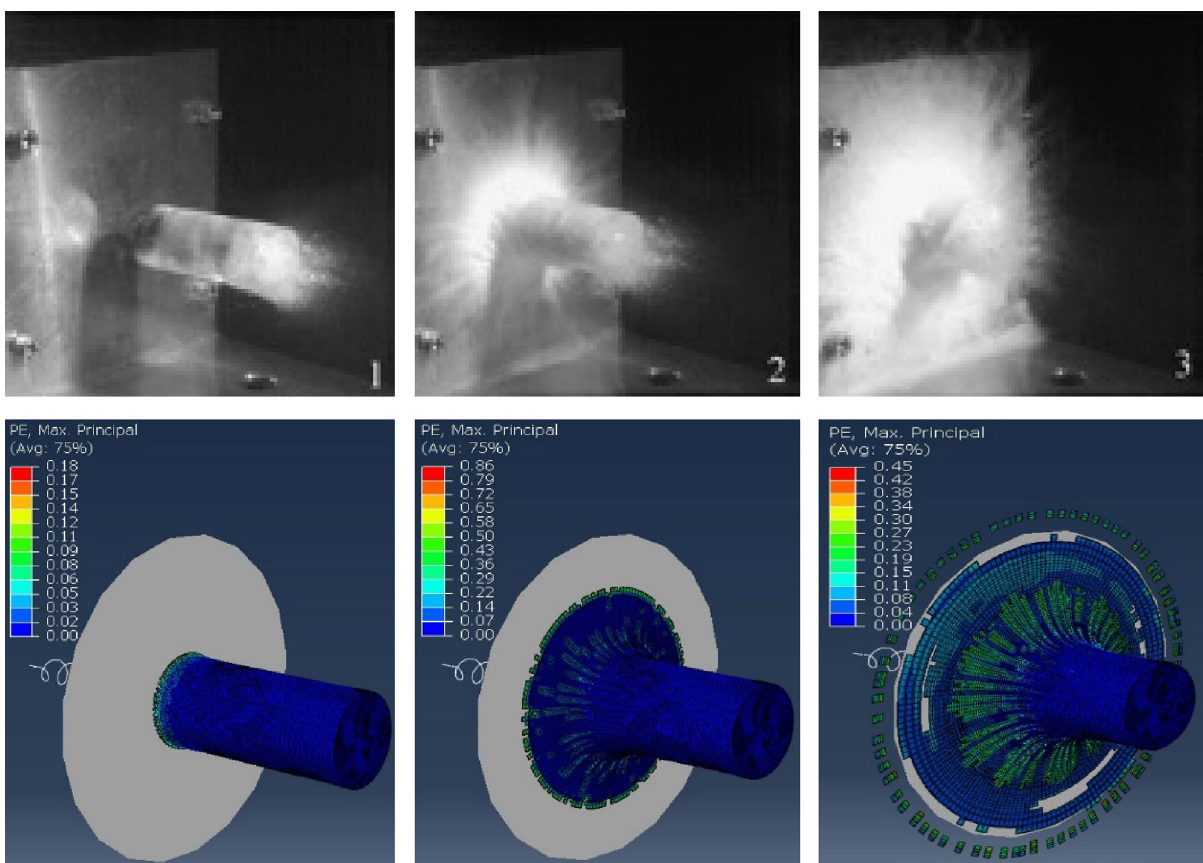
Figure 6. Comparison of the impact captured by experimental results obtained by Carney et al. 25 and FE models.